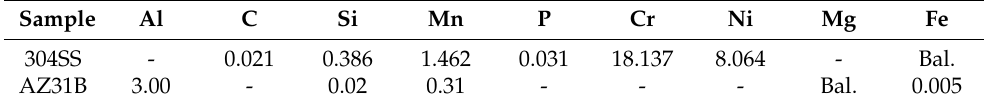
Table 1. Nominal chemical composition of the 304 stainless steel and AZ31B